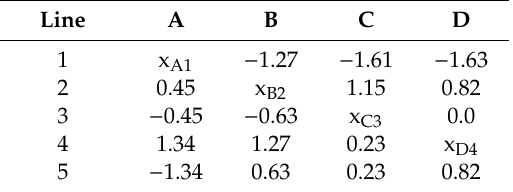
Table 2. Adjusted (standardized) phenotypic data from Table 1.